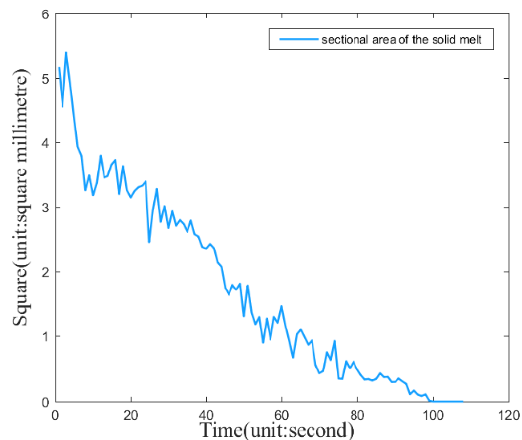
Figure 7. Silicon dioxide during melting in a hot cell plot of area change at each moment. A correlation analysis of the data from the center of mass [23] was performed and the silica cross-sectional area versus time was calculated in square millimetres for the first 101 images (Figure 7). Additionally, we have precisely calculated the perimeter of the silica melt as a function of time (Figure 8). These properties are a good reflection of the melting properties of the substance, and also the rate at which it